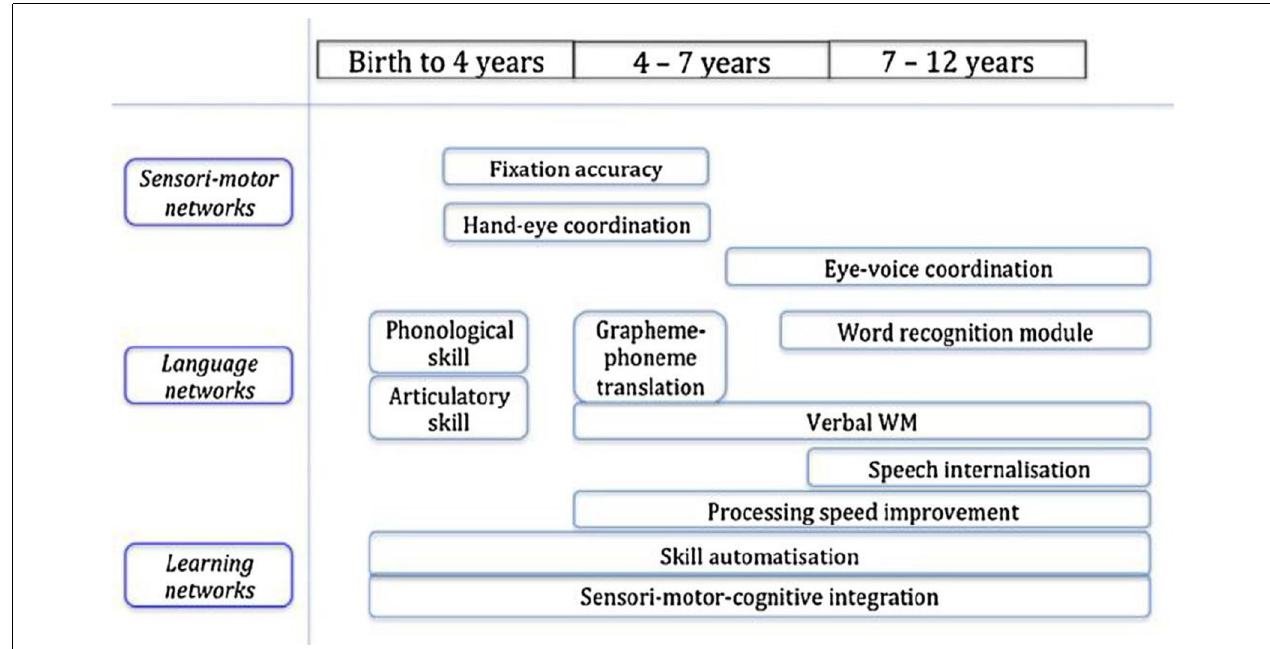
FIGURE 5 | Proposed components relating to the development of reading (Mariën et al.,